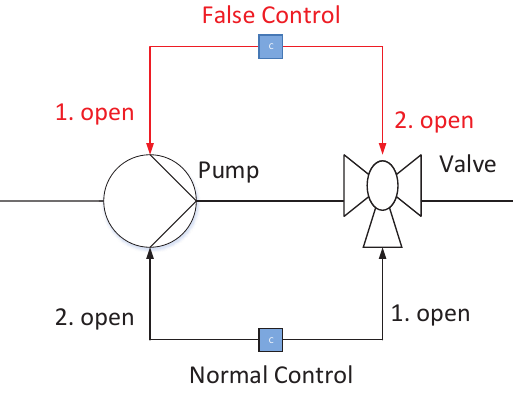
Figure 2. A part of a chemical reactor system [15]. Adapted with permission from [15], Copyright Elsevier,